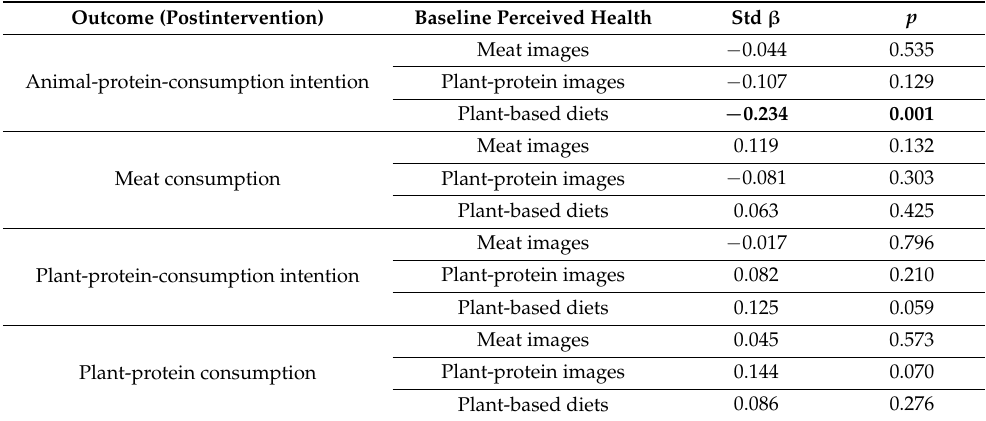
Table 2. Influence of baseline perceived health on changes in consumption intention and